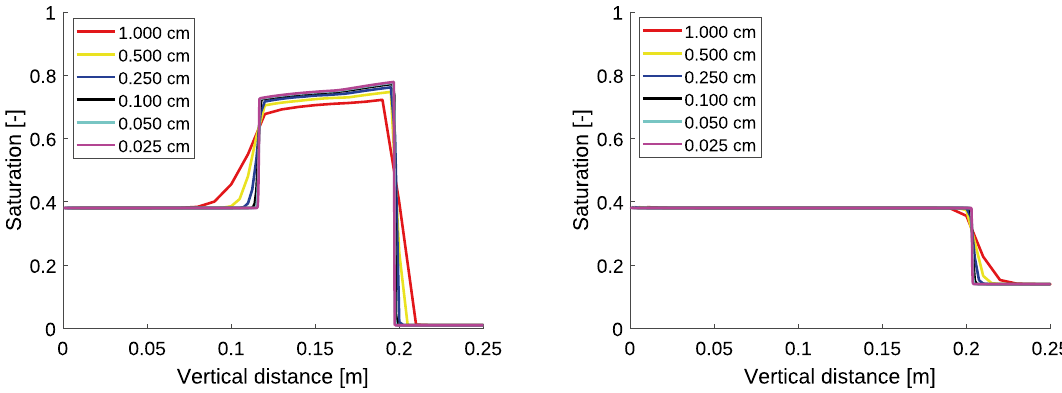
10 minutes for (cid:31) x 0 for initial saturation = → 5 m/s. The flux out of the bottom block 6 10 − = × 5 minutes for (cid:31) x 0 = → 5 m/s. The flux out 6 10 − = ×